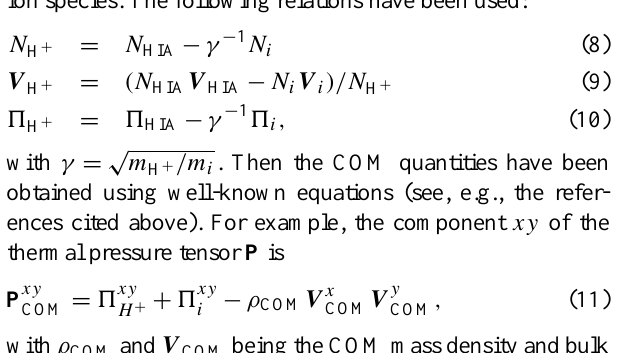
Fig. 2. The procedure for determining the HT frame consists of finding the transformation velocity, V HT , that minimizes the residual electric field in the least-squares sense (Sonnerup et al., 1987; Khrabrov and Sonnerup, 1998a). To show the result, the left plot compares, component by component, the measured convection electric field E c = − V × B with the convection electric field E HT = − V HT × B based on the de- termined HT velocity. The slope of the fit line (i.e., 1 . 01), and the correlation coefficient (0 . 99) testify to a good identi- fication of the HT frame. The ratio between the mean square electric field calculated in the HT frame ( D ) and in the ini- tial frame ( D 0 ) shows that 99% of the initial electric field has been transformed away in the HT